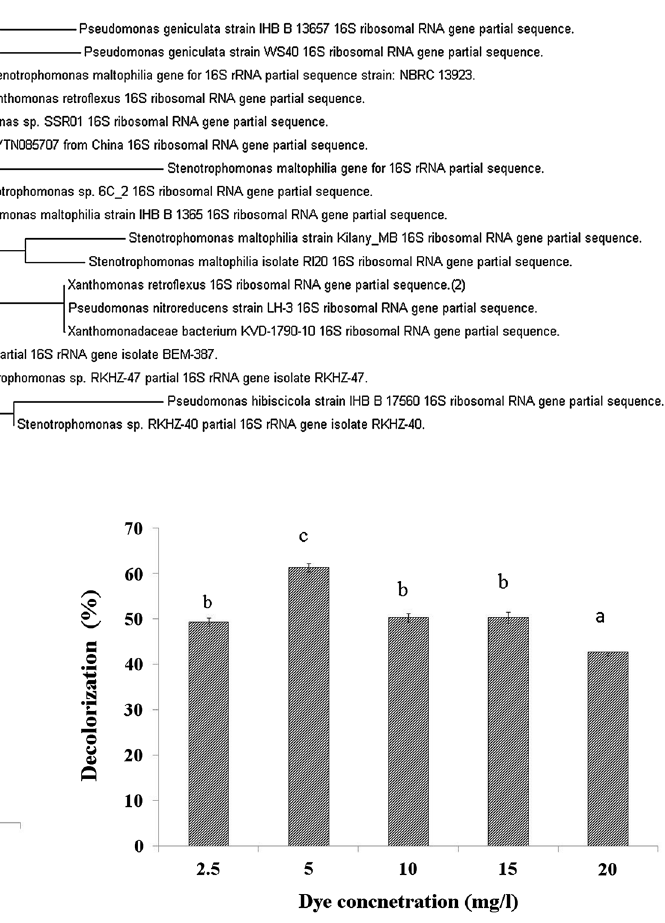
Fig. 4 Effect of methylene blue concentration